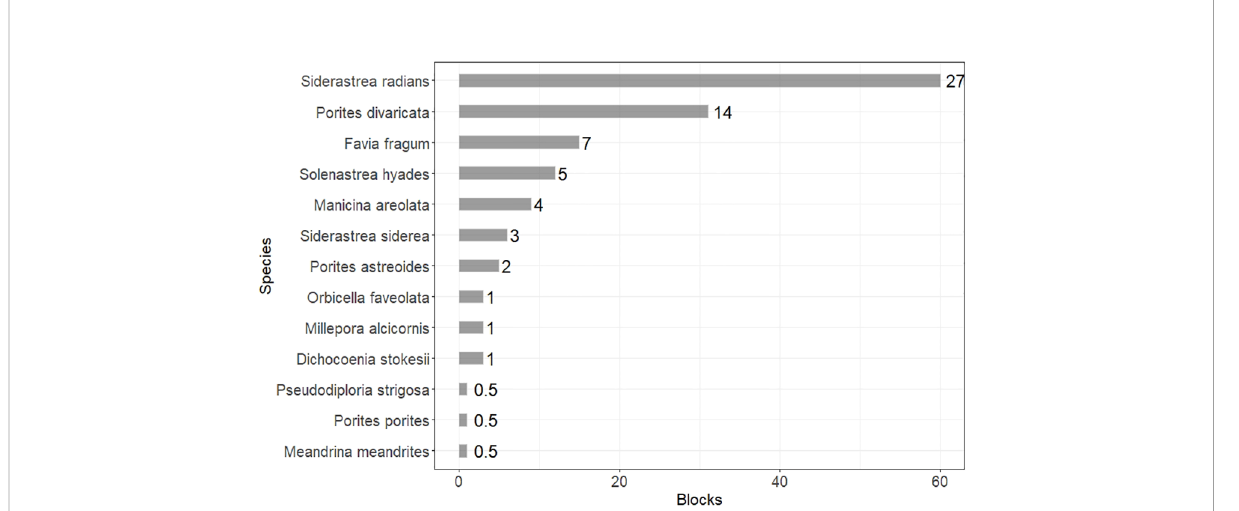
FIGURE 4 Bar plot of coral species occurrence. Occurrence is measured in overall number of blocks that each species was recorded, while the aggregated percent occurrence (i.e., number of blocks where the species was recorded to total number of blocks surveyed) is shown next to each